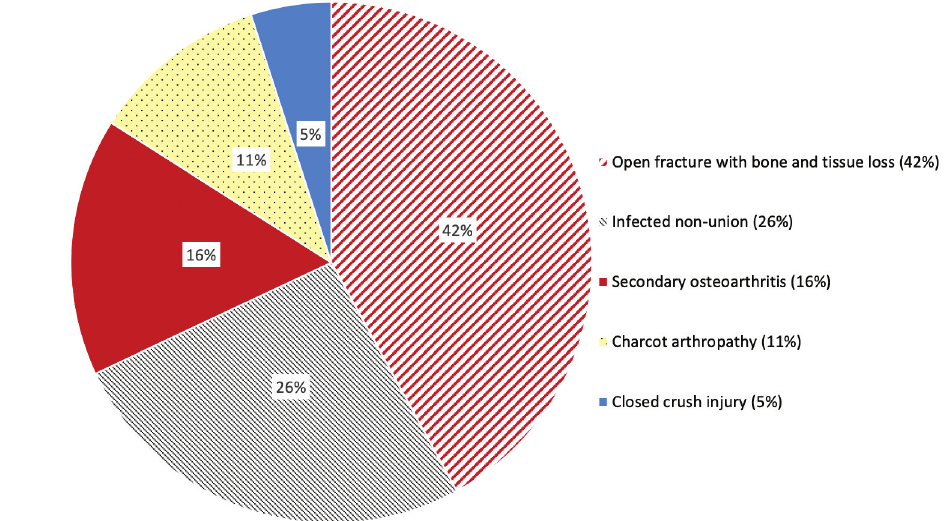
Indications for ankle Fig. 2: